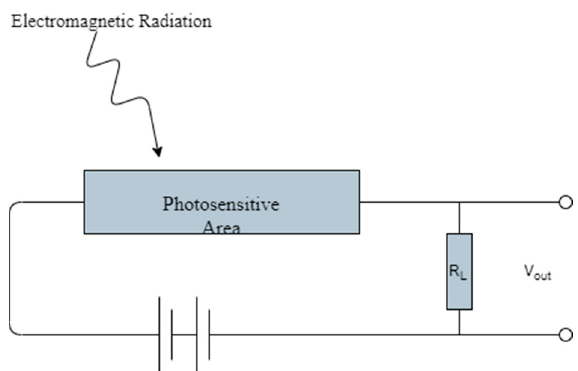
Figure 10. Schematic of working principle of PIN photodiode [70].